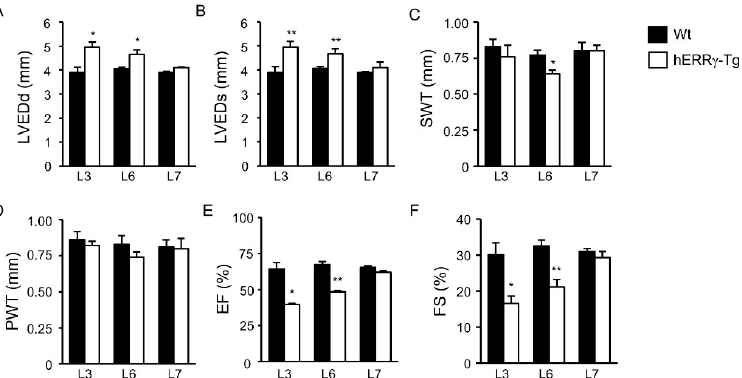
Figure 3. Structural and functional alterations in hearts of hERR γ -Tg mice. Cardiac dimen- sions and function in 8–10-week-old hERR γ -Tg mice were assessed by transthoracic M-mode and two-dimensional echocardiography. ( A ) LVEDd: left ventricular end-diastolic internal diameter; ( B ) LVEDs: left ventricular end-systolic internal diameter; ( C ) SWT: interventricular septum wall thickness; ( D ) PWT: posterior wall thickness; ( E ), EF: ejection fraction; ( F ) FS: fractional shortening). Data are mean ± SEM of 3–4 animals/group; * p = 0.05; ** p =